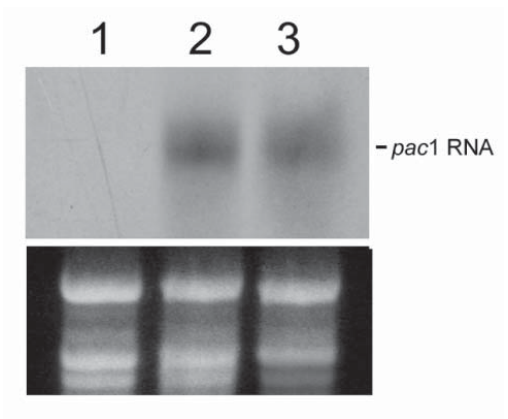
Fig. 3. Northern blot hybridization of total RNA (10 µg) from potato leaf tissues with the specific pac 1 32 P-la- belled probe: 1, untransformed potato; 2, 3 transformed potato clones A and B respectively. Lower panel repre- sents ethidium bromide-stained rRNA as loading con-